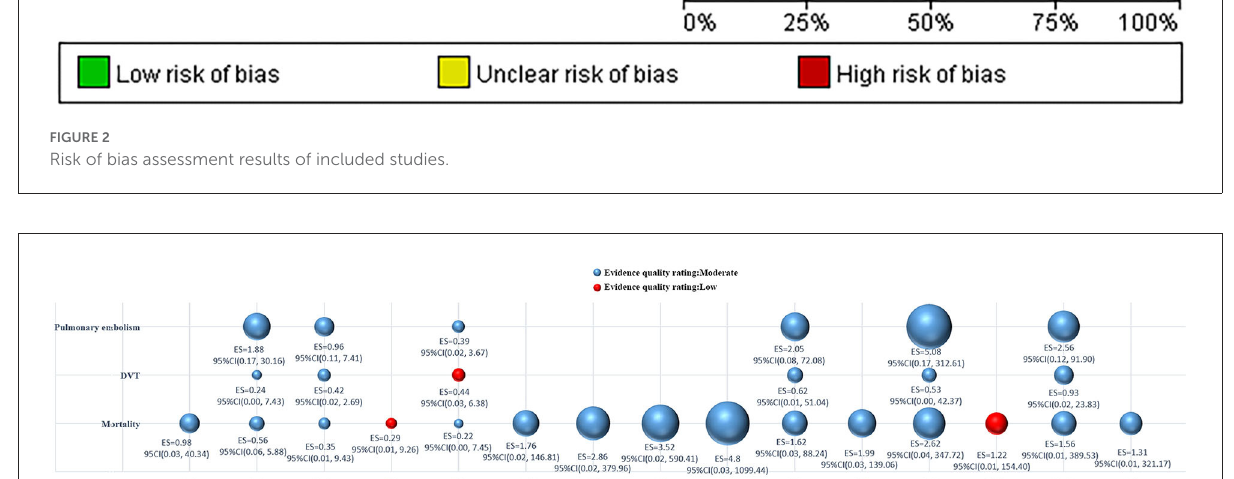
FIGURE3 Bubble plots of the quality of evidence assessment for all comparisons. DVT, deep vein thrombosis; ES, effect size; CI, confidence interval; A, erythropoietin (12,000u); B, placebo; C, erythropoietin (30,000u); D, erythropoietin (40,000u); E, erythropoietin (70,000u); F, erythropoietin